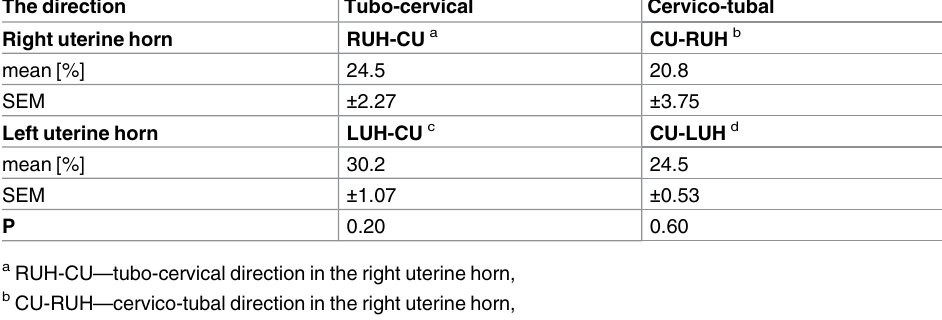
Table 2. The percentage (mean % ± SEM) of bursts propagation directions along the uterus in relation to the total number of highly synchronized uterine contraction